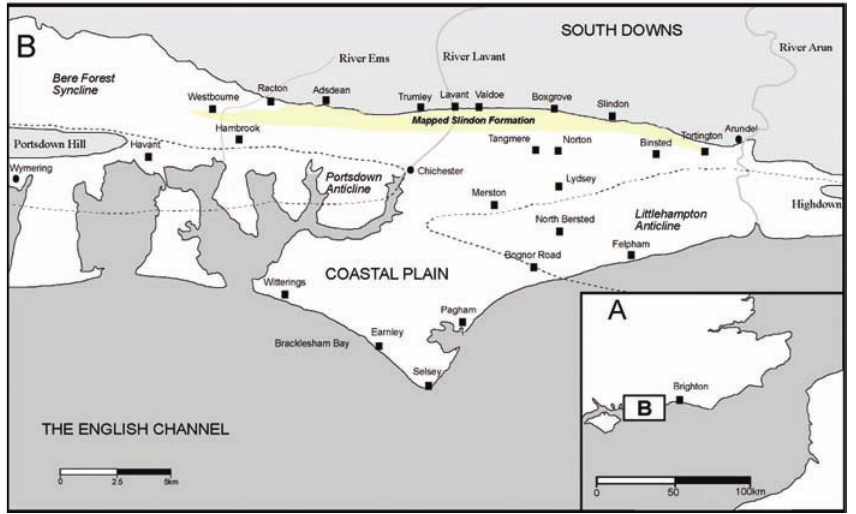
Figure 1 Location map showing the position of Boxgrove and the mapped distribution of the Slindon Formation, from work carried out as part of the RBMP